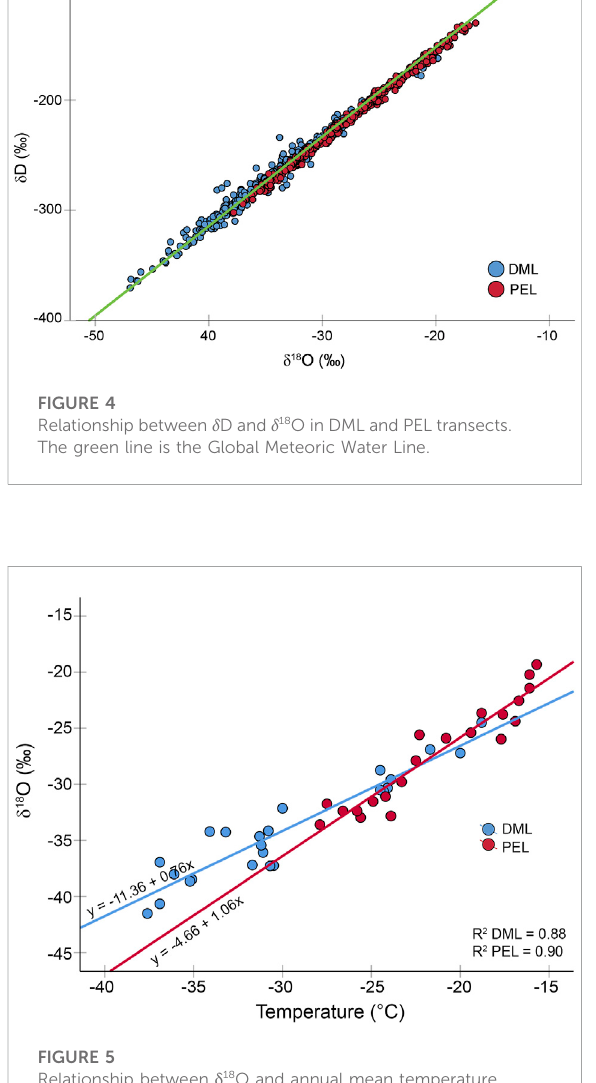
regions (R = 0.931 in DML and R = 0.951 in PEL, p < 0.001) (Table 3). An in-depth correlation analysis between the δ 18 O values and the monthly average temperatures for 2008 showed signi fi cant correlations at 3 or 4 phase lag in the DML and PEL